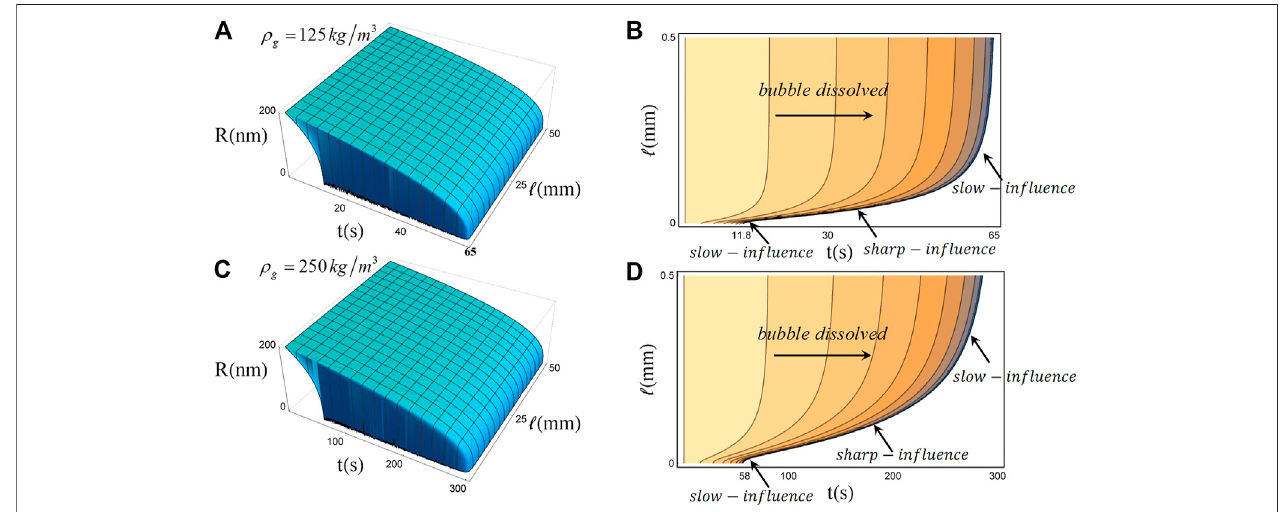
FIGURE 3 | Evolution of single bulk nanobubble per unit time. (A) Development of a single bubble with an initial radius of 200 nm ( ρ g = 125 kg/m3): The gas transport near the nanobubble caneffectively delay the dissolution ofthe nanobubble. Forthe nanobubble with an inner density of 125 kg/m3, the effect of gasdiffusion can prolong the nanobubble lifetime by nearly six times. (B) Contour diagram of Figure 3A . Gas diffusion has a small effect range (0.5 mm) on limiting nanobubble dissolution. (C) Development of a single bubble with an initial radius of 200 nm ( ρ g = 250 kg/m3). (D) Contour diagram of Figure 3C : as the gas diffusion distance increases gradually from 0, its in fl uence range on the life of a single nanobubble has a slow-sharp-slow process. The higher the density inside the bubble, the more obvious this process is.